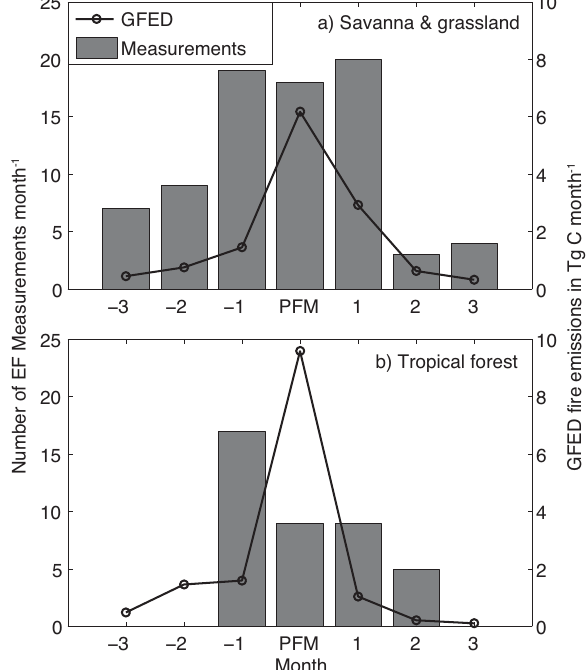
Fig. 3. Number of EF measurements (bars) and GFED3.1 fire emis- sions (lines) in TgCmonth − 1 for a 7-month period centered around the peak fire month (PFM), for the (a) savanna and grassland and (b) tropical forest